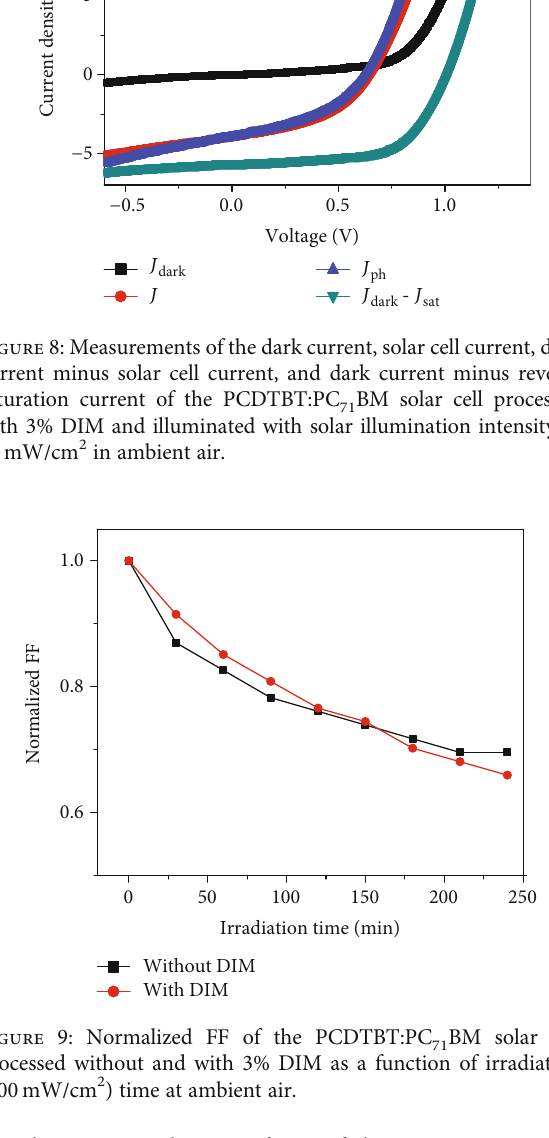
BM solar cell 71